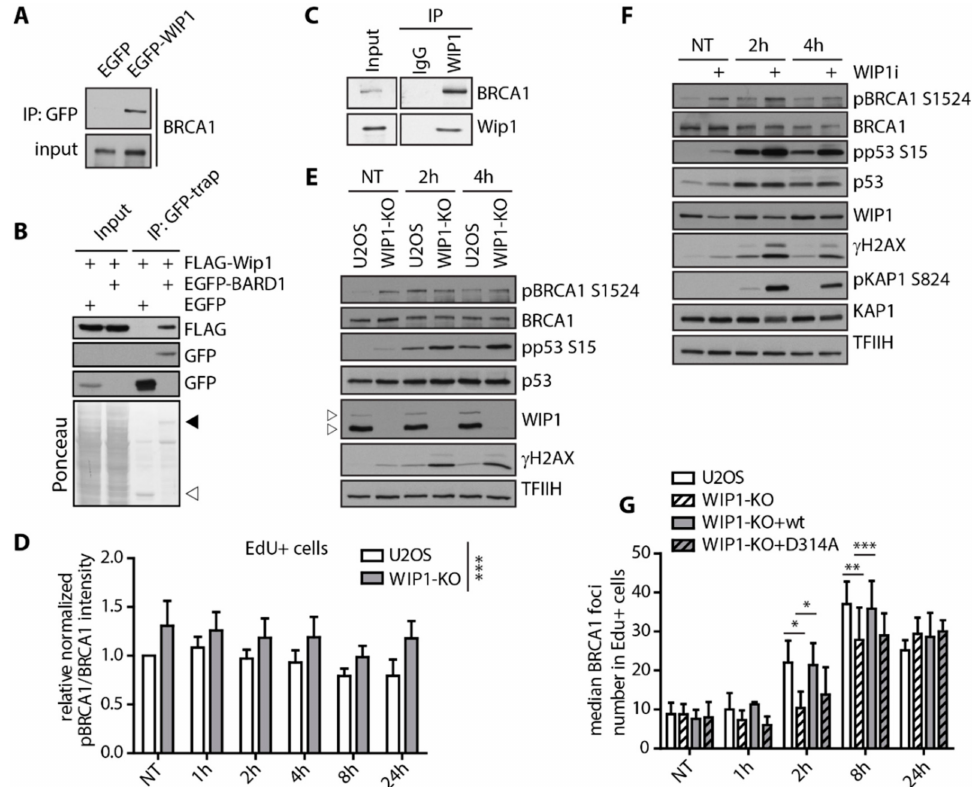
Figure 3. WIP1 interacts with BRCA1 and dephosphorylates S1524. ( A ) Co-immunoprecipitation of WIP1 and BRCA1. HEK293 cells were transfected with either empty GFP or GFP-WIP1, subjected to immunoprecipitation using GFP-Trap and analyzed by Western blotting with BRCA1 antibody. ( B ) Co-immunoprecipitation of WIP1 and BARD1. HEK293 cells were co-transfected with either empty GFP or GFP-BARD1 and Flag-WIP1, subjected to immunoprecipitation using GFP-Trap and analyzed by Western blotting with indicated antibodies. Ponceau staining with indicated positions of GFP (empty arrowhead) and GFP-BARD1 (full arrowhead) are shown. ( C ) Co-immunoprecipitation of endogenous WIP1 and BRCA1. U2OS cell lysates were incubated with 2 µ g of a control antibody (IgG) or a ffi nity-purified antibody against WIP1 for 2 h. Protein complexes were isolated by protein A / G resin and analyzed by immunoblotting. ( D ) Quantification of BRCA1 pS1524 signal intensity in replicating (EdU + ) cells after irradiation. U2OS parental and WIP1 knockout cell lines were pulse-labeled with EdU for 30 min before irradiation. At indicated time-points, cells were pre-extracted, fixed and stained with pBRCA1 S1524 and BRCA1 antibodies. Click chemistry was used to visualize EdU. Median total intensity of BRCA1 pS1524 was normalized to total BRCA1 and is plotted +/ − SD. Statistical significance evaluated by two-way ANOVA. ( E ) Western blot analysis of U2OS parental and U2OS-WIP1-KO cell lines after irradiation. Cells were irradiated and whole cell lysates were analyzed using Western blotting with indicated antibodies. Arrowheads indicate two isoforms of WIP1 present in U2OS. ( F ) Western blot analysis of MCF7 cells after irradiation with or without combined treatment with WIP1i. Cells were pretreated with WIP1 inhibitor for 30 min before irradiation and whole cell lysates were analyzed by Western blotting with indicated antibodies. ( G ) Quantification of BRCA1 foci in replicating (EdU + ) cells after irradiation. Parental U2OS and U2OS-WIP1-KO cells and cell lines complemented with wild-type or phosphatase-dead (D314A) mutant of WIP1 were pulse-labeled with EdU for 30 min before irradiation. Cells were fixed after pre-extraction at indicated time-points and stained with BRCA1 antibody. Click chemistry was used to visualize EdU. Mean of median total intensity +/ − SD is plotted. Statistical significance evaluated by two-tailed t